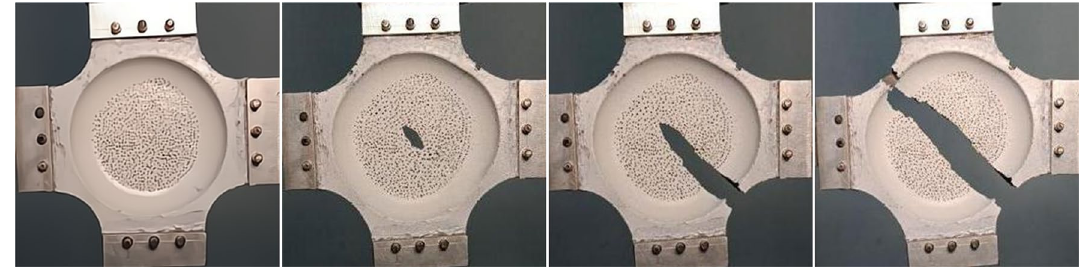
Figure 9. Failure process of propellant